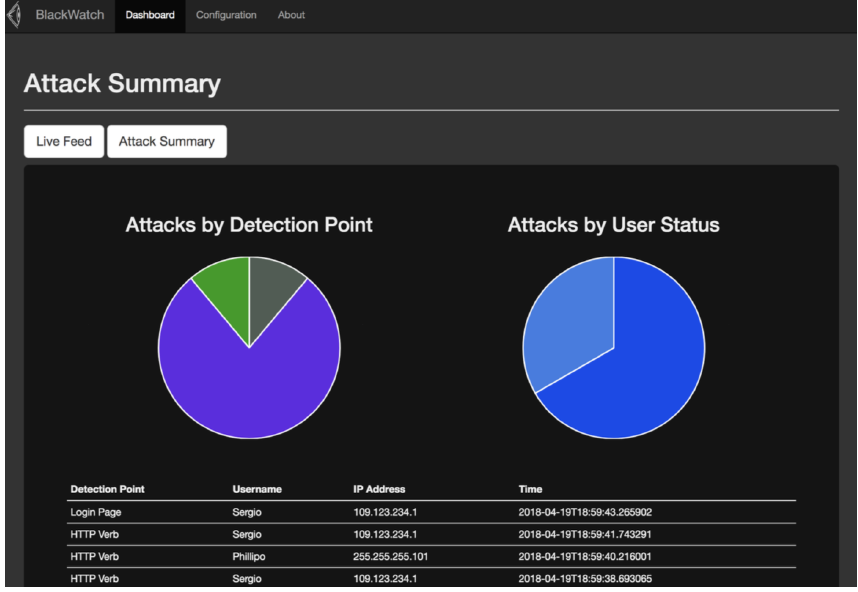
Figure 7. The Attack Summary interface within